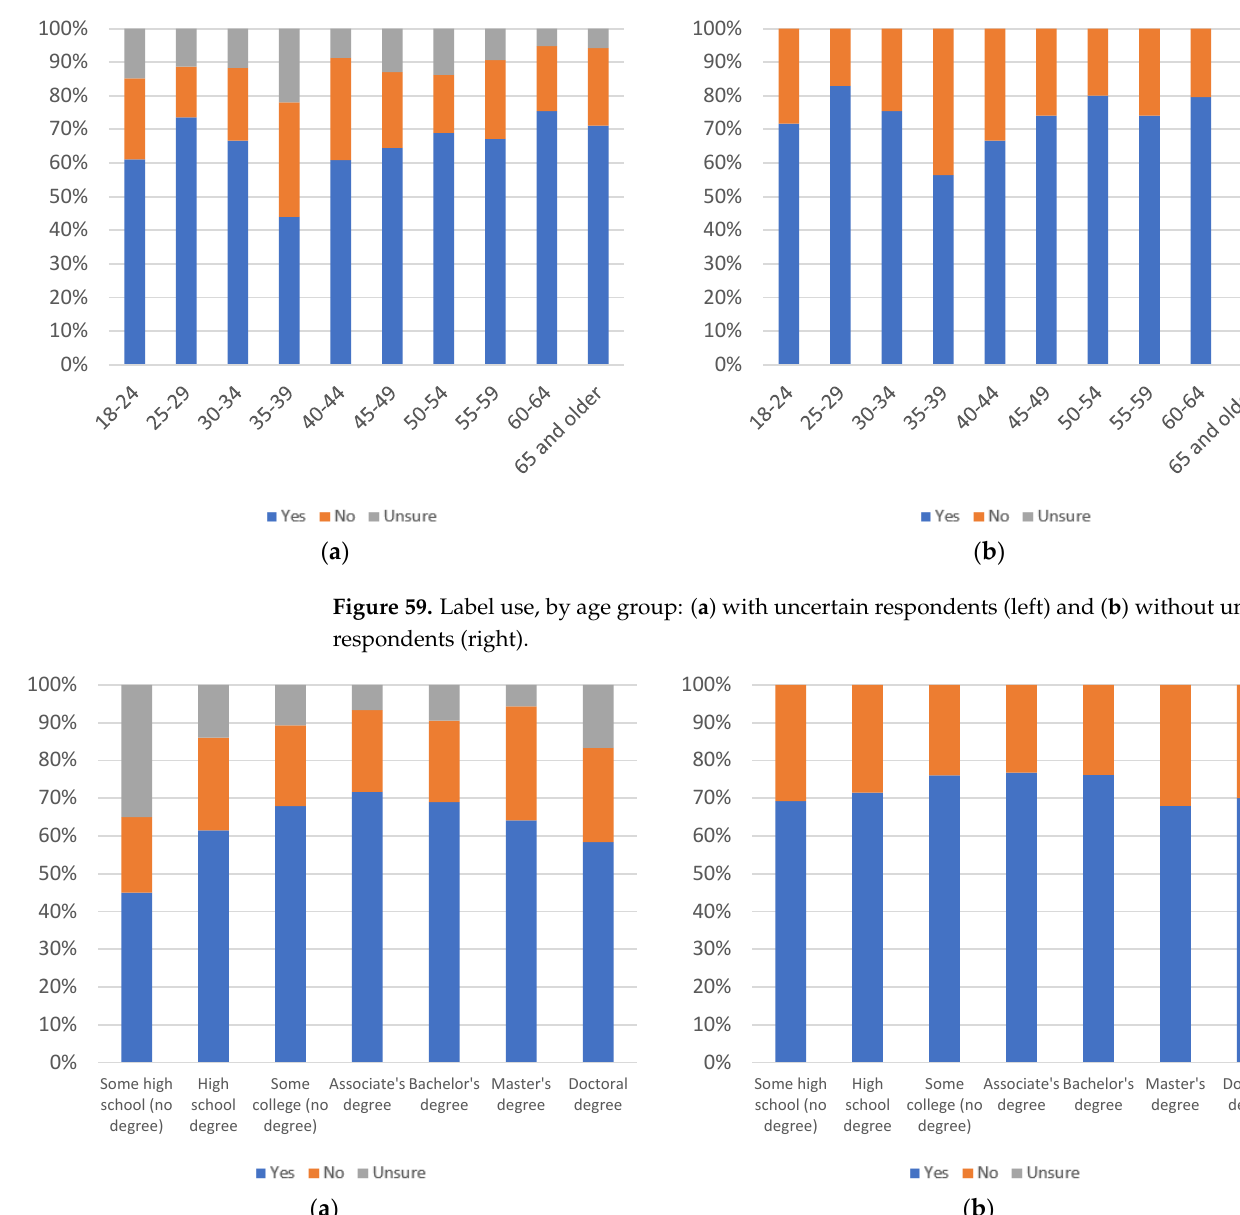
( b ) Figure 61. Label use, by gender: ( a ) with uncertain respondents (left) and ( b ) without uncertain respondents (right). Figures 62 –64 consider respondents’ perspective as to the likelihood of others to use warning label 1, with respondents answering the question “would others review this label when viewing news articles on social media ?”. In terms of age, results appear somewhat consistent, when uncertainty is not consid- ered. There is a plateau from the 45 – 49 to 65 and older age groups. There is a slow decline from the 25 – 29 to 40 – 44 age groups, and a drop at the 18 – 24 age group. Uncertainty levels are generally high. Once uncertainty is introduced, the results change significantly, with three waves of increase at 18 – 24 to 30 – 34, 35 – 39 to 45 – 49, and 50 – 54 to 65 and older. Each of these waves bottoms out either just above or just below 50% yes responses, with only